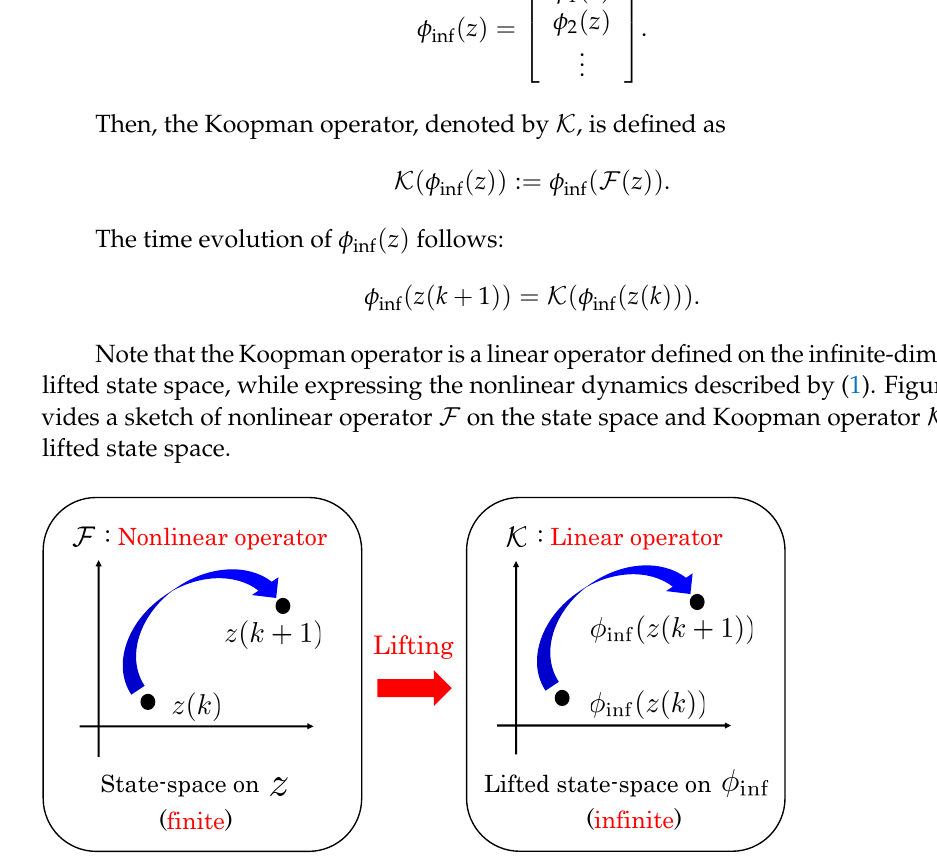
Figure 1. Nonlinear operator F on state space and Koopman operator K on lifted state